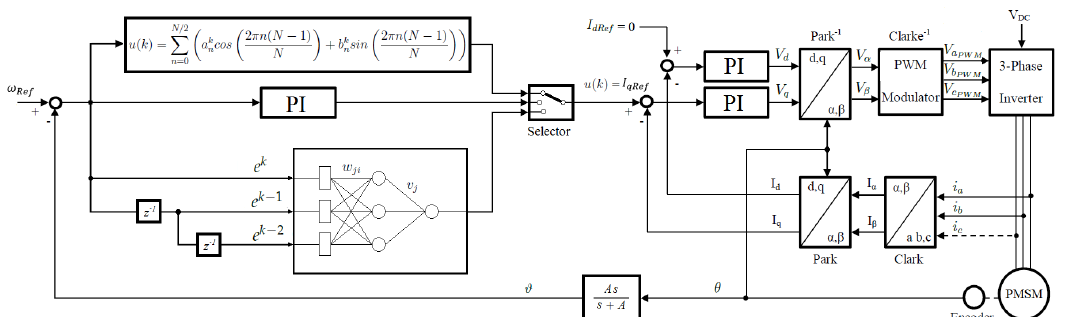
Figure 1. Block diagram of the FOC (Field Oriented Control) for the velocity control of a PMSM (Permanent Magnet Synchronous Motor) with three different master controllers, the FSLC (Fourier Series Learning Controller), a traditional PI (Proportional Integral) and an ANN (Artificial Neural